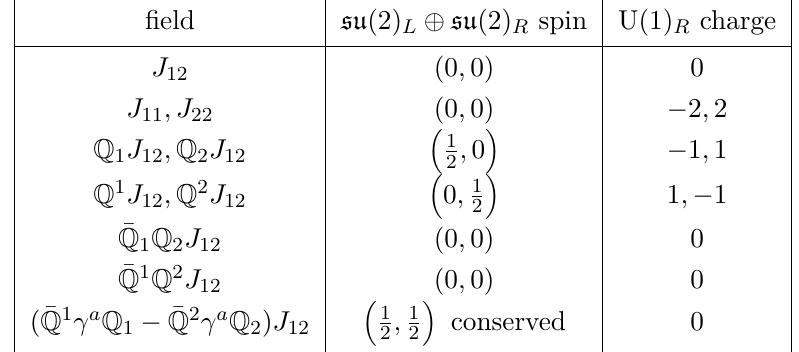
Table 2 . The field content of the flavor current multiplet. It contains 8 + 8 independent real